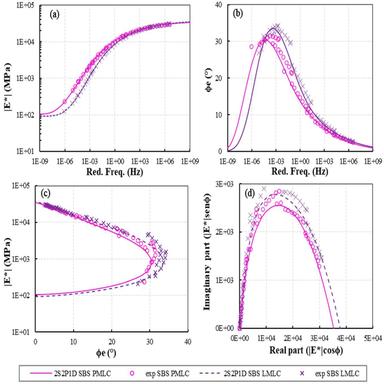
Stiffness of the "SBS" asphalt mixture with LMLC and PMLC samples: (a) dynamic modulus master curve; (b) phase angle master curve; (c) Black space; (d) Cole-Cole.